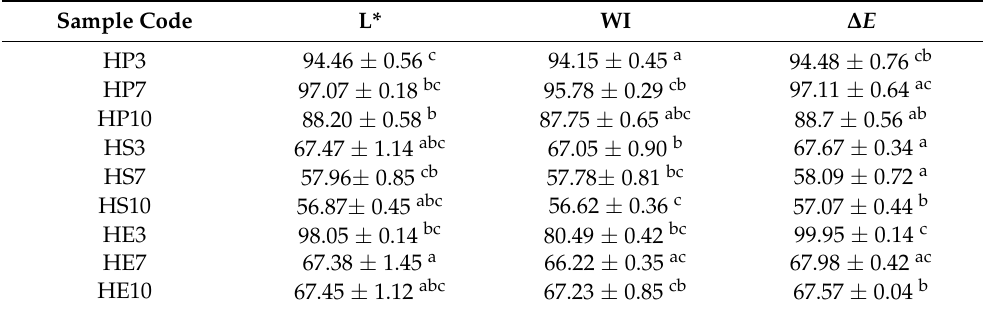
Table 2. Color parameters of hydrocolloids extracted from mango ( Mangifera indica ) var. hilaza. at different